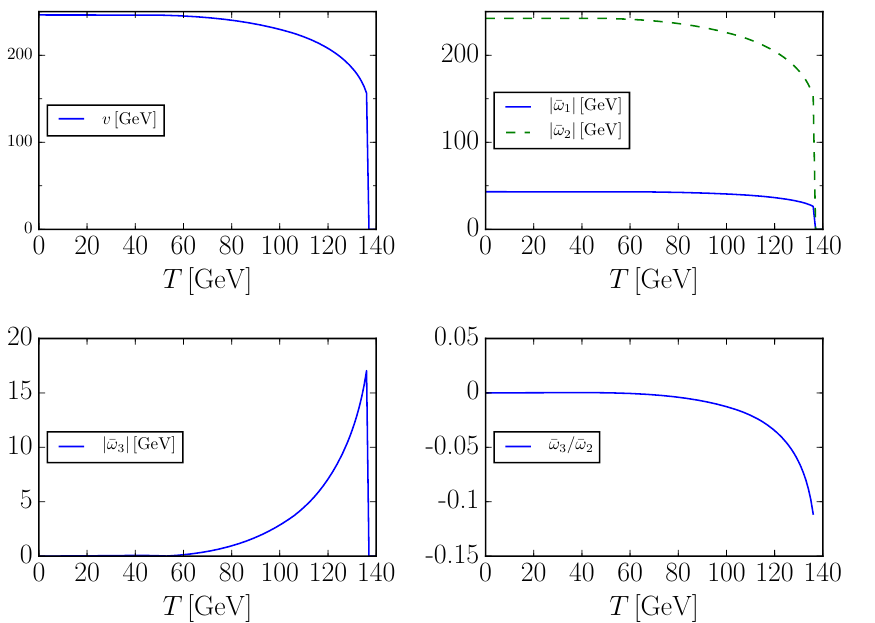
Figure 2 . Type I, H 1 = h : the development of the VEV as a function of the temperature. In clockwise direction: the total VEV v ; the absolute values of the CP-conserving VEVs, (blue/full) and (cid:22) ! 2 (green/dashed), the absolute value of the CP-violating VEV, j j